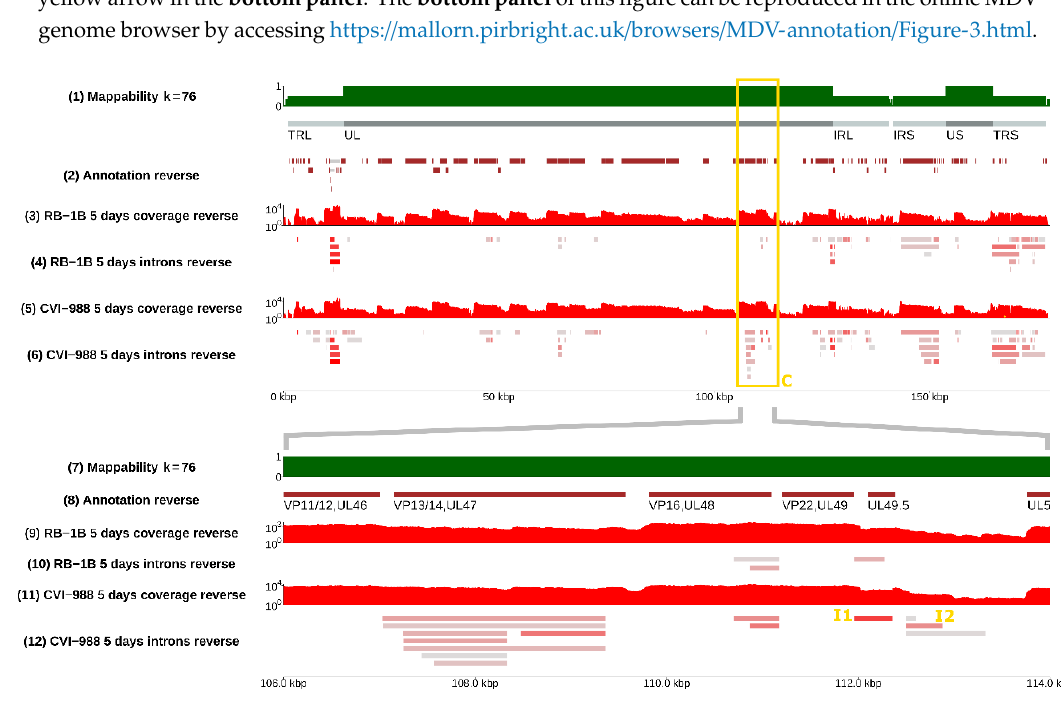
Figure 4. More splicing events on the reverse strand of MDV. Top panel : negative strand of the whole MDV genome; bottom panel : the region between 106 and 114 kbp. The bottom panel is a magnified version of the content of the yellow frame C present in the top panel and in Figure 1. In this region, more splicing events were observed in MDV strain CVI-988 during its infection of CEF cells compared to MDV strain RB-1B. In particular, one of the unique introns (named I1 in Table 3), identified in MDV strain CVI-988 between the UL49.5 and UL49 genes, was detected with a high read coverage (613 spliced reads), whereas in RB-1B the same isoform does not exist and a shorter intron can be observed. Introns I1 an I2 are also highlighted in yellow in the bottom panel . The bottom panel of this figure can be reproduced in the online MDV genome browser by accessing https://mallorn.pirbright.ac.uk/browsers/MDV-annotation/Figure-4.html.